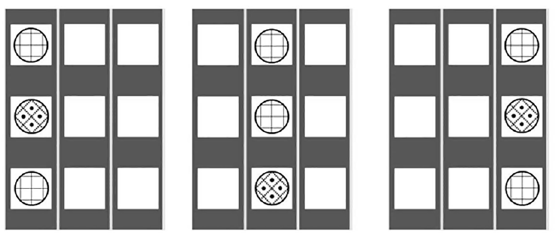
Figure 1. Odd One Out